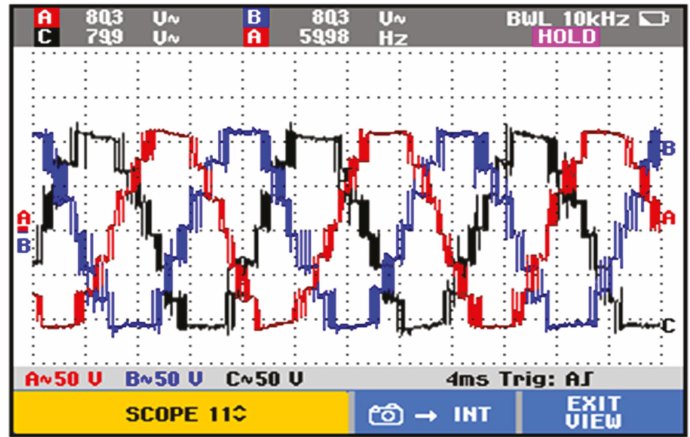
Figure 26: Experimental three-phase line-line voltages generated from con fi guration C.